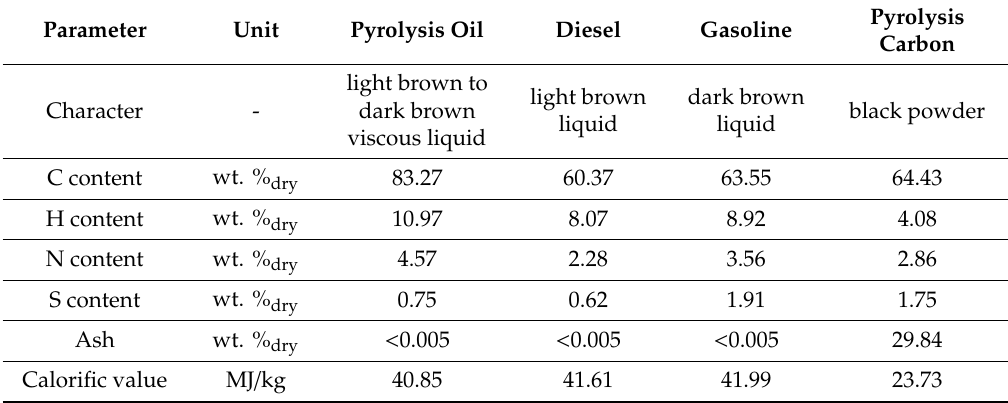
Table 2. Final products of waste tires pyrolysis